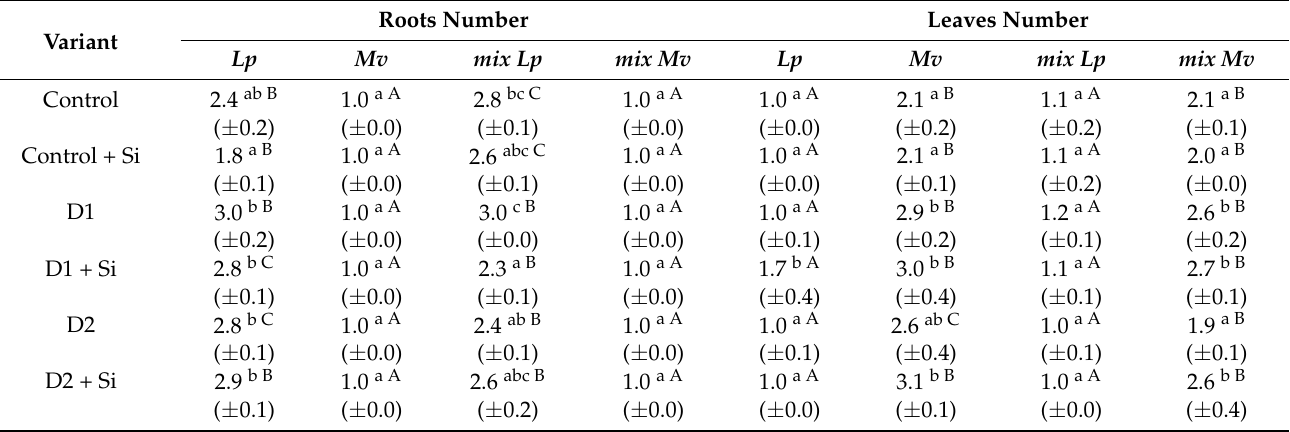
Figure 1. Results of principal component analysis (PCA): ( a ) presenting relationships between the traits: GE—germination energy, GC—germination capacity, NS—normal seedlings, AS—abnormal seedlings, RN—roots number, LN—leaves number, RL—root length, LL—leaf length, FW—fresh weight, DW—dry weight; ( b ) for the tested combinations of silicon (Si) and induced drought condi- Lp—L. perenne in the mixture, mix Mv — M. x varia in the mixture. Table 3. Effects of different variants of drought conditions on number of roots and leaves of Lolium perenne ( Lp ) and Medicago x varia ( Mv